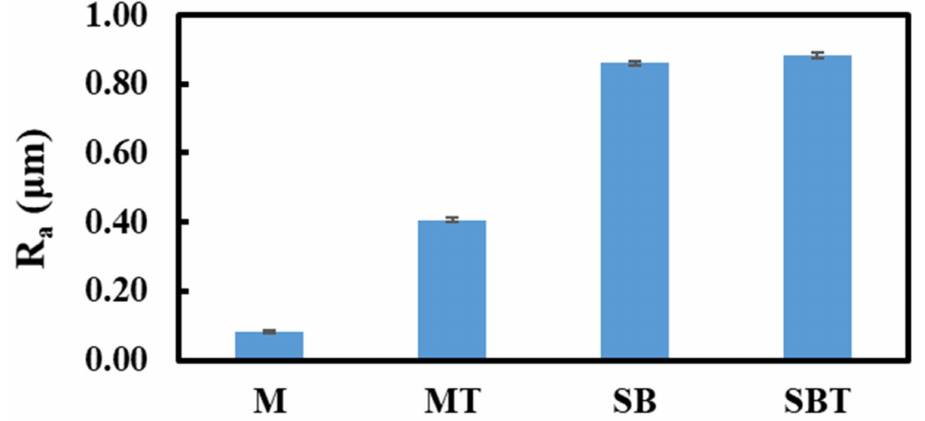
Figure 4. The roughness of pretreated and treated Ti64 samples at different